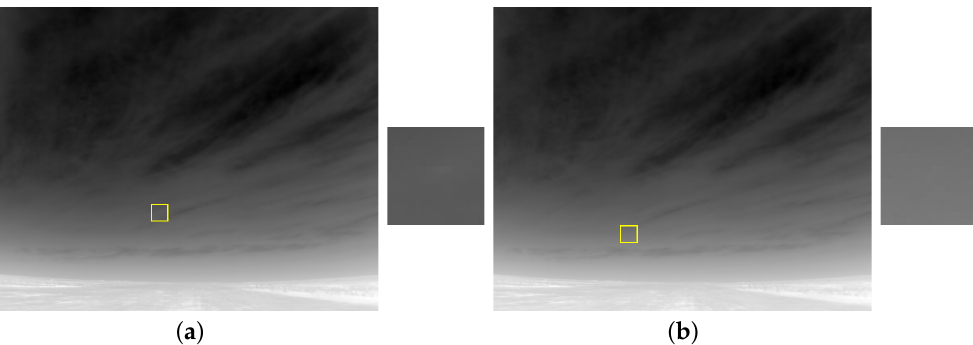
Figure 3. Infrared images of small size and minimal thermal signatures target at long range (( a ) 520 m, ( b ) 853 m). Zoomed target regions are shown on the right. The target’s spatial contrast is minimal and the scene contains cluttered bright background regions. (For display, images are minmax